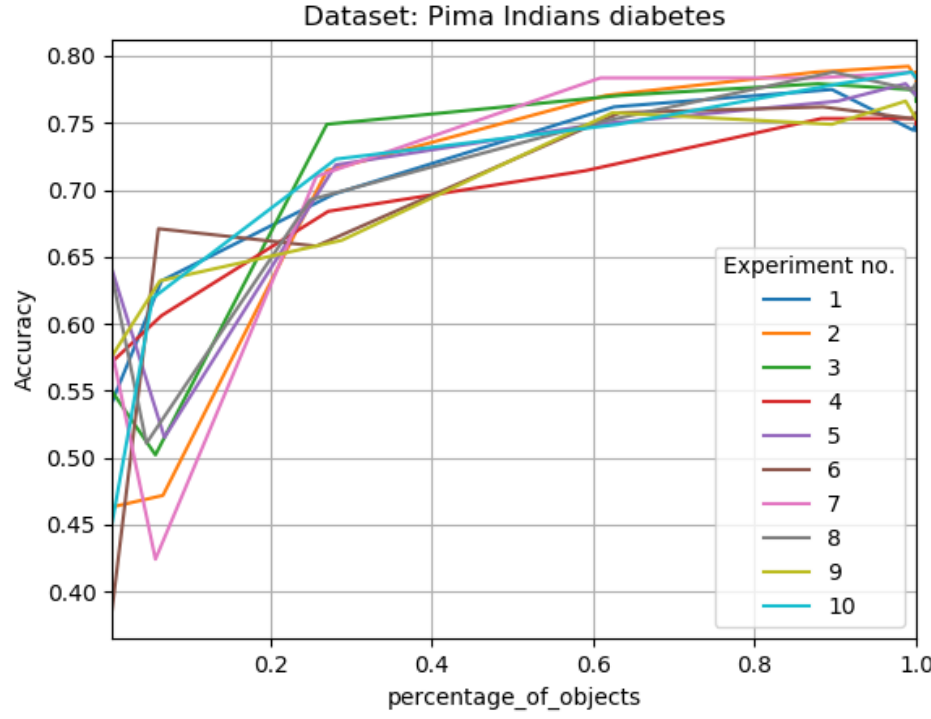
Figure 7. Results for 10 learning cycles, using 10 splits; for Pima Indians Diabetes data set; In ‘percentage of objects’ ax, we have the percentege size of granulated data vs accuracy of classification in ‘Accuracy’ ax; in. The results are not perfectly evenly matched or at the same points on the x-axis, due to the fact that the size reduction levels of the training systems varied.